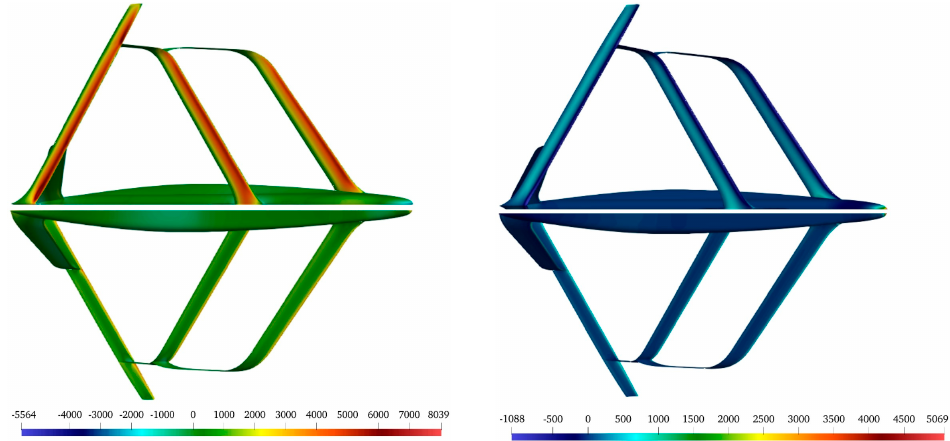
Figure 17. BWA/SL aircraft in cruise flight condition S 3 (M = 0.7 at 43,000 ft) with an angle-of-attack α = 0°. Distribution of the lift ( left ) and drag ( right ) forces (in Newtons), as exerted on the suction (top halves) and pressure (bottom halves) sides of the aircraft.